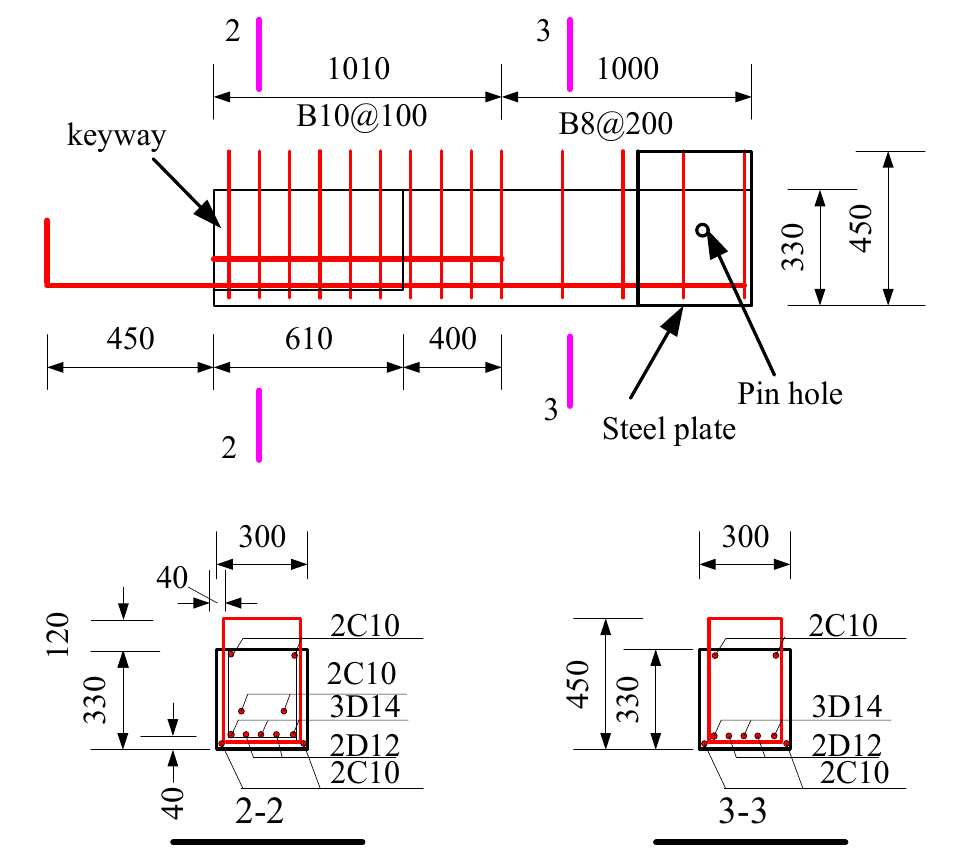
Figure 3. The precast beam details of YZ1 (Unit: mm). Note: D = HTRB600, HTRB600 represents steel bars with a strength grade of 600 MPa.